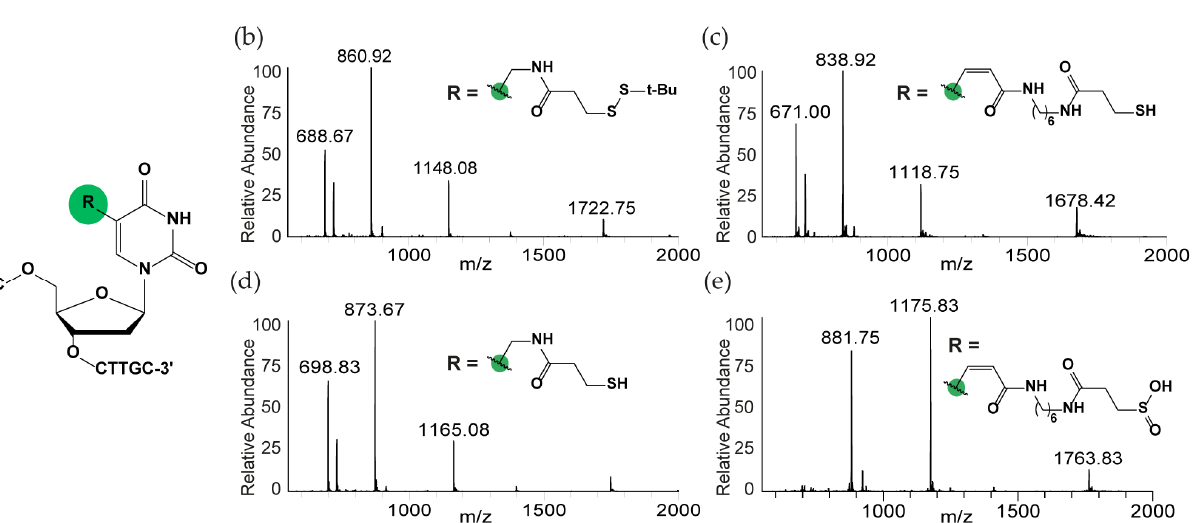
Figure 2. Incorporation of 11 and S-Bz thiol modifier C6 dT to internal oligonucleotide positions. ( a ) Structure of the oligonucleotide with the modified monomer in its fifth position. ( b ) Mass spectrum of the major product of the crude oligonucleotide synthesized using 11 with ETT as the activator, cleavage was performed using AMA for 24 h. DMT-TCACT( t -Bu-SS)CTTGC mw: 3447.64, [M-2H] 2 − :